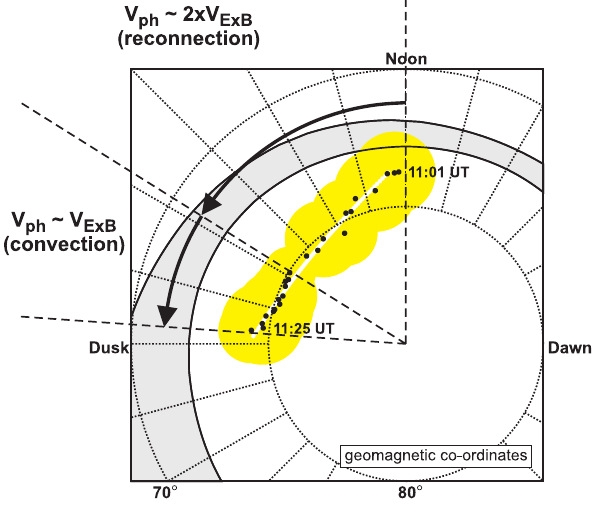
Fig. 1. As described in Paper 1, following a sharp southward turn- ing of the IMF, a patch of radar backscatter appeared near mag- netic local noon. The small black dots mark the central position of the feature, and the large yellow circles represent its approxi- mate extent as it propagated anti-sunward into the postnoon sector. The phase speed V ph of the feature appears to be comprised of two regimes: one of fast, highly variable motion, where the mean phase speed is approximately twice the convection speed V E × B , and a second regime of slower, more steady motion, where the average phase speed is very similar to the convection